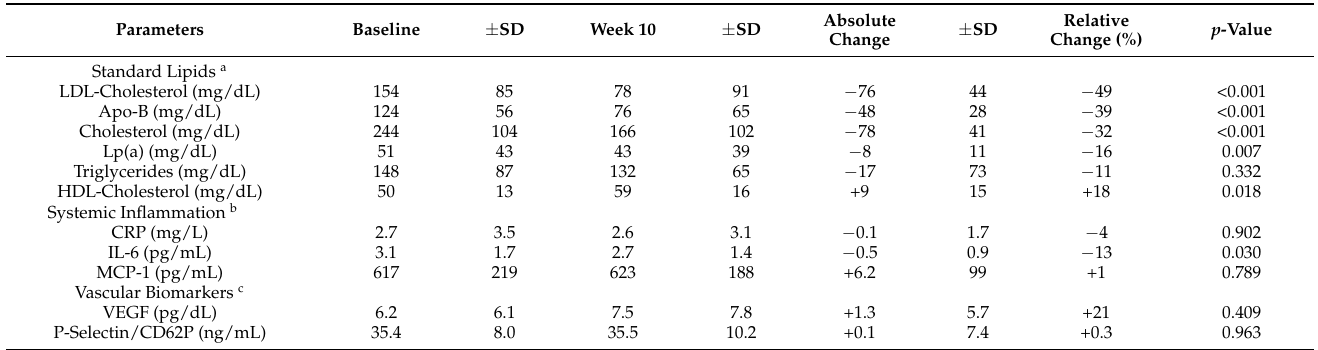
Table 3. Effects of Alirocumab on Lipids, Systemic Inflammation, and Vascular Biomarkers.